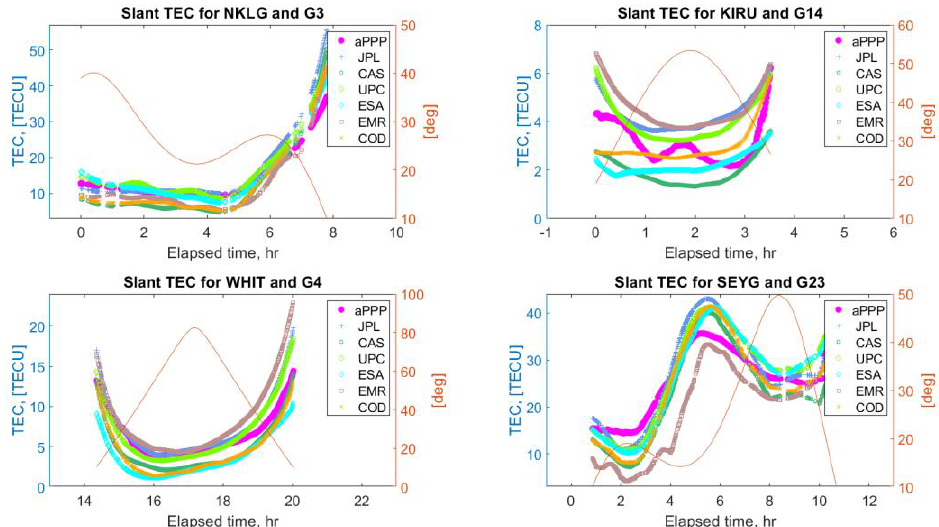
Figure 12. Comparison of STEC values retrieved using the ionosphere retrieval equation (labeled as aPPP) and GIM STEC values from six different Ionosphere Associate Analysis Centers (IAAC) for IGS stations NKLG, KIRU, WHIT, SEYG, and GPS satellites G3, G14, G4, and G23. The elevation angles of the corresponding satellites are also plotted.